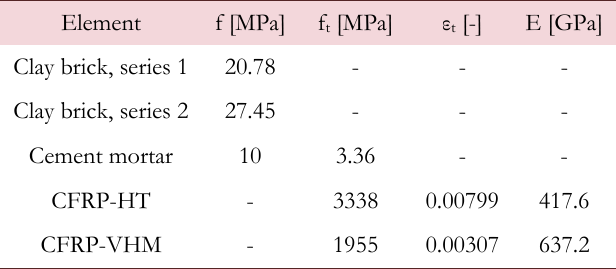
Table 6.A: Mechanical properties of constituents for the experimental tests [38].